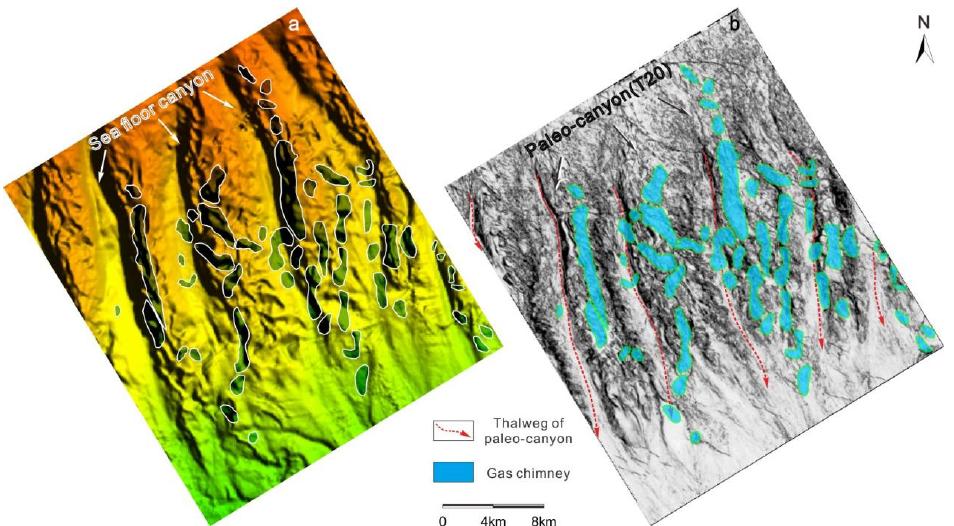
Figure 8. Distribution of gas chimneys. ( a ) Bathymatry of sea floor; ( b ) the background is a coherence slice which has been extracted following the Horizon T20 in the 3D seismic data. In the slice, eastern margins of the paleo-canyons can be easily identified and the red dashed lines (approximate parallel to the canyon margin) with arrows pointing toward downstream standing for the thalweg of